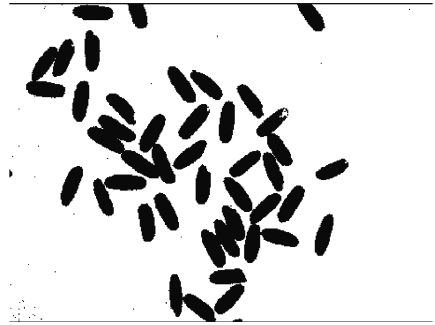
Figure 24: The region growing algorithm.